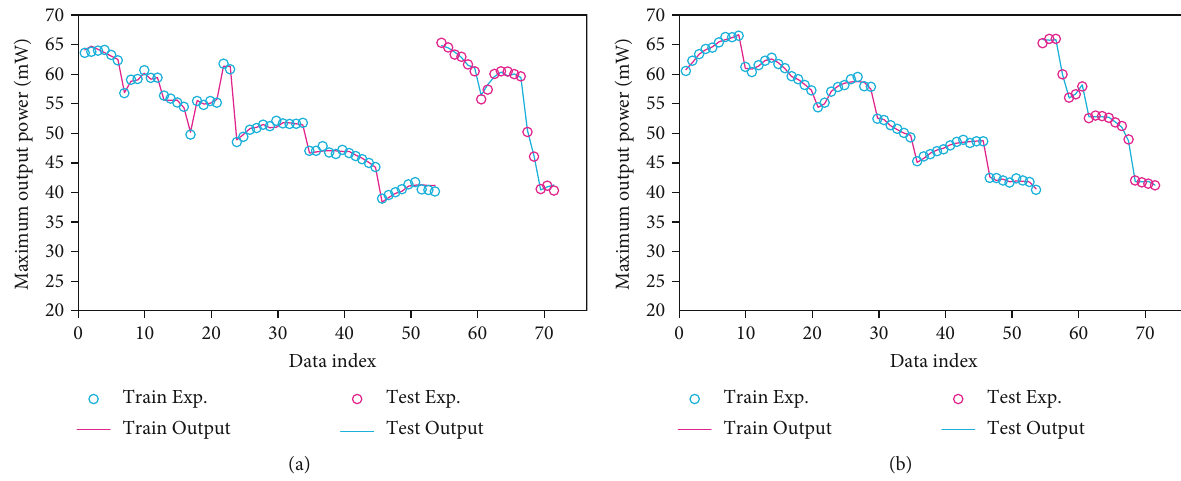
Figure 4: The predicted maximum output power by LSSVM for (a) monocells and (b) multicells.